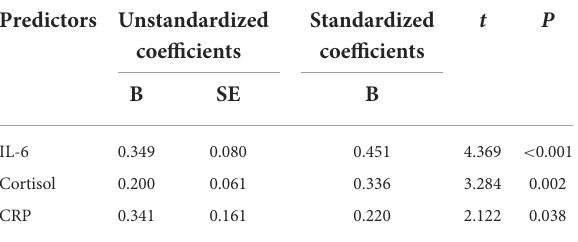
TABLE 3 Multiple stepwise regression analysis showing the variables independently associated with SHAPS score in